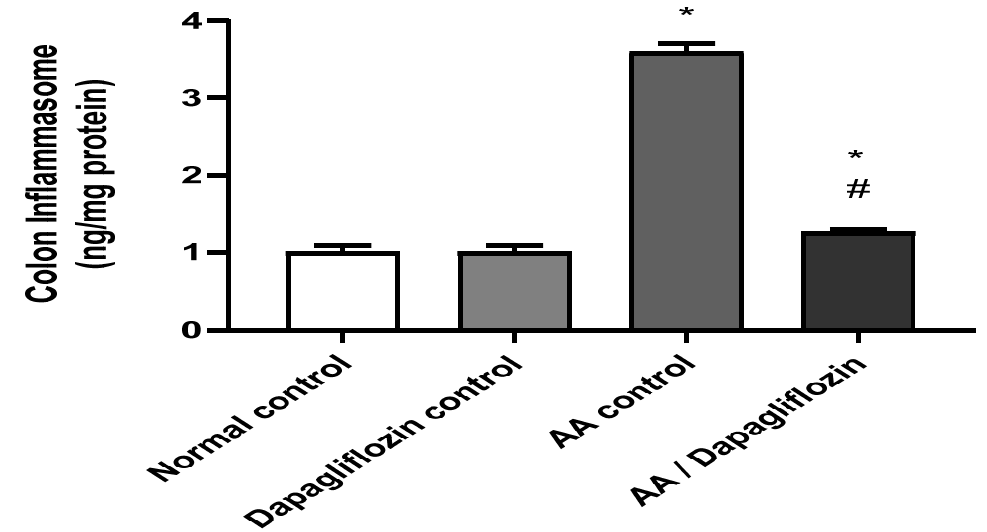
Figure 5. Effect of DAPA on AA-induced change in inflammasome in colon tissue. Data are expressed as mean ± SEM. Statistical analysis was performed using one-way ANOVA followed by the Tukey– Kramer multiple comparison test ( p < 0.05). Superscript letters refer to the level of significance: * DAPA Significantly different from the normal control group; # DAPA significantly different from the AA control group).